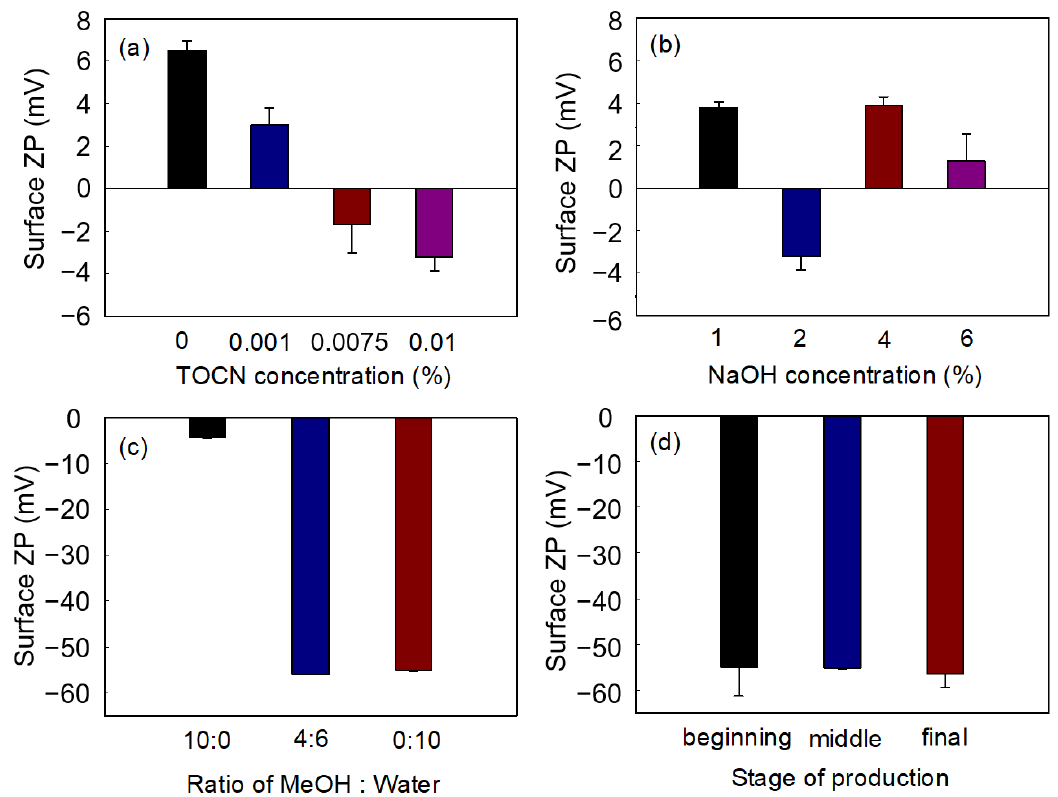
Figure 7. ZP values of fiber surfaces ( a ) at various TOCN concentrations using 2% NaOH as coagu- lation solution, ( b ) at various NaOH concentrations using 0.01% TOCN mixture as the coagulation solution, ( c ) at various ratios of MeOH to water as the washing agent, and ( d ) at different stages of production using 0.01% TOCN and 2% NaOH solution as coagulation